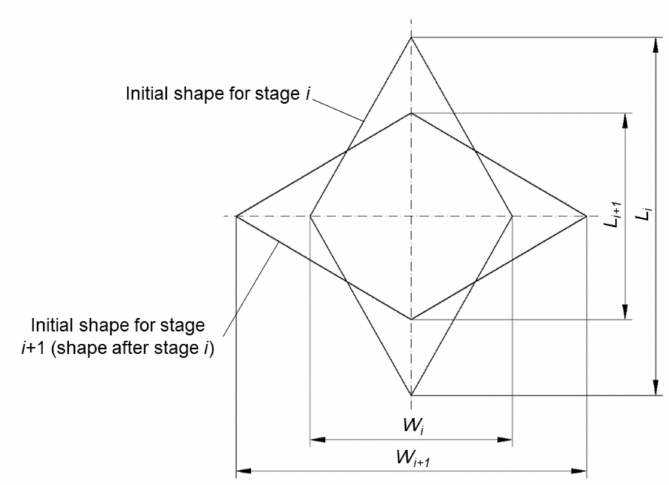
Figure 7. Geometry of mesh cells in two subsequent stages of the